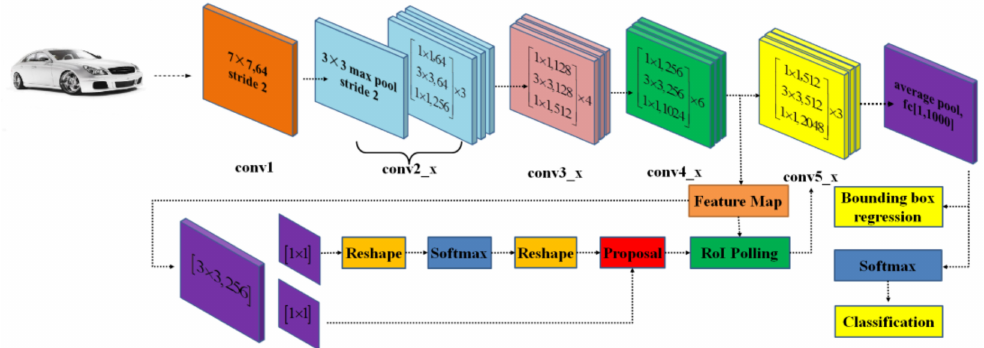
Figure 3. This is the construction of Faster R-CNN, and ResNet-50 is at the top of the figure to get feature map, and in the bottom of the figure is region proposal network (RPN), region of interest (RoI), and Softmax, respectively, from left to